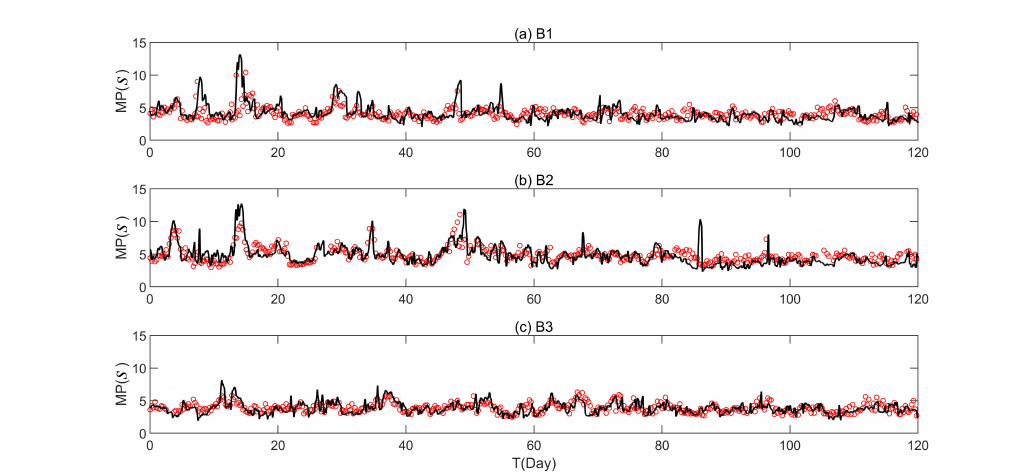
Figure 3. Comparison of hindcast and observed mean period (MP) curves (black line: simulation; red circles: observations; ( a ) B1, ( b ) B2, ( c ) B3 represent buoys 1 to 3 in Figure 1).